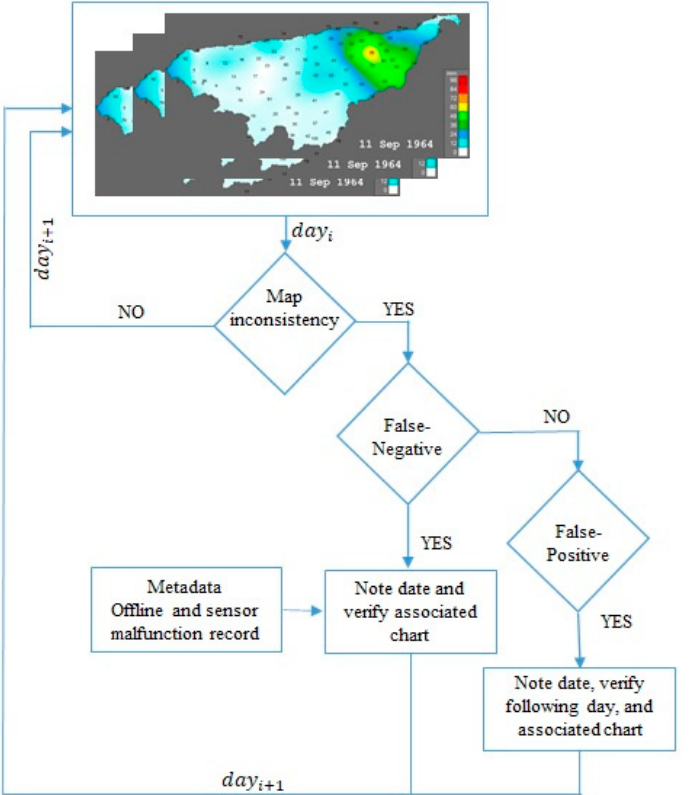
Figure 2. The flow chart of visual inspection of the daily interpolated rainfall maps to identify the inconsistencies in the recordings. The identified inconsistencies were cross-checked using previous and flowing day interpolated maps. False-Negative recording errors are errors due to turned off rain gauges or missing gauges whose records are referred to in the metadata, while False-Positive recording errors are errors resulting from date coding.